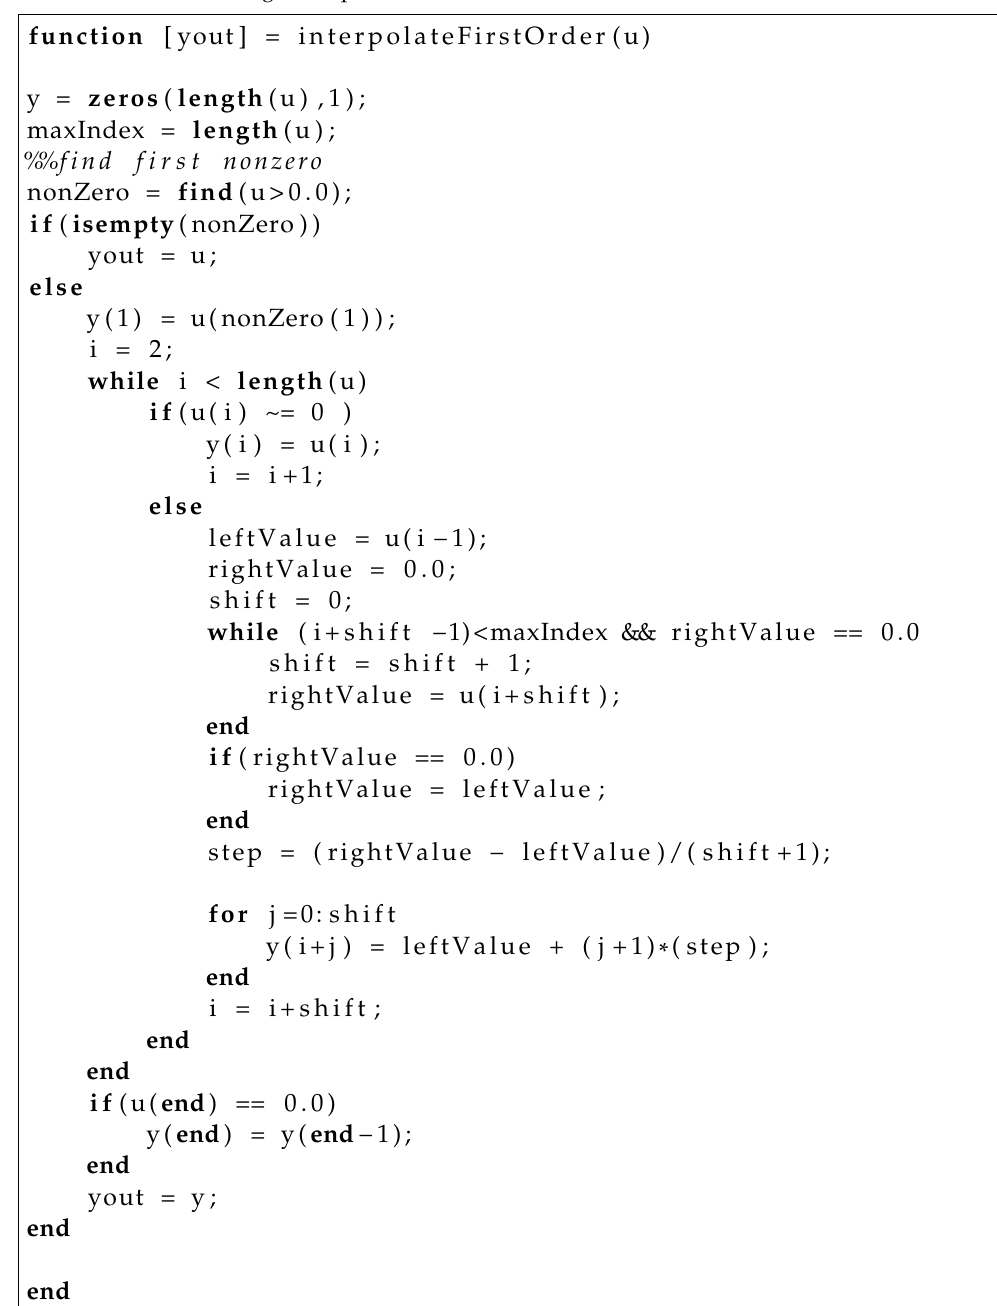
Listing A1. Script interpolating data obtained from the OptiTrack system between the first available left and first available right